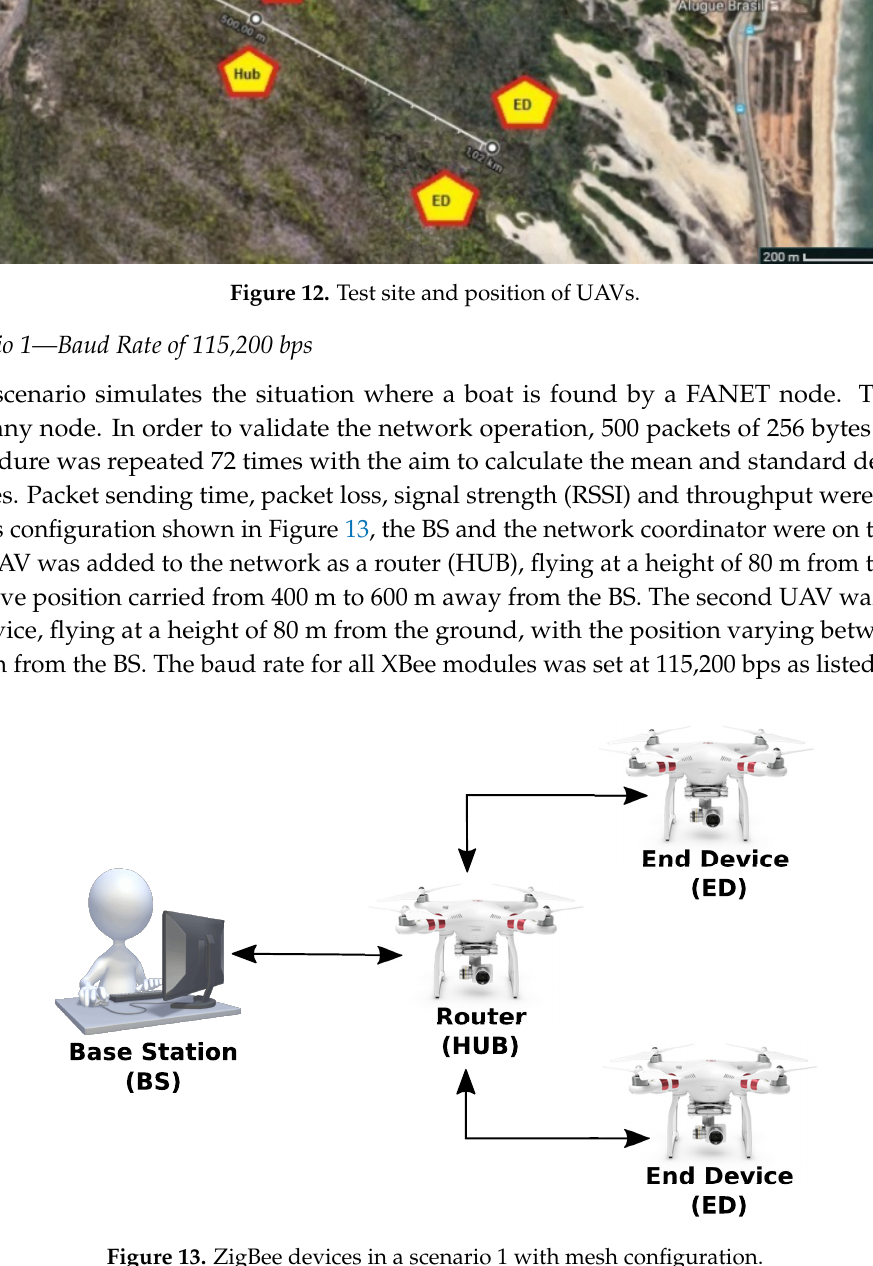
Figure 13. ZigBee devices in a scenario 1 with mesh